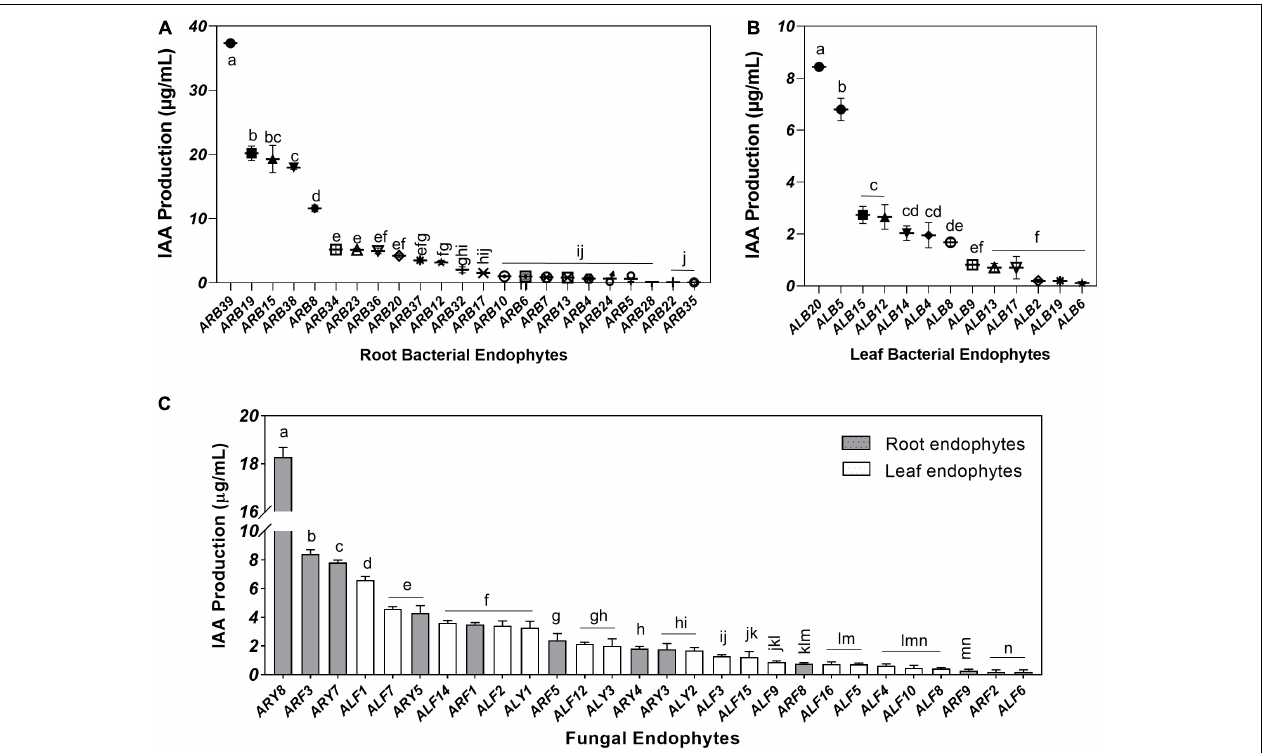
FIGURE 6 | Indole acetic acid (IAA) production by microbial endophytes of A. euchr oma quantified using Salkowski reagent. IAA production by root (A) and leaf (B) associated bacterial endophytes. (C) IAA production by root (gray) and leaf (white) associated fungal endophytes. Bars with different alphabets indicate a significant difference ( p < 0.05) as calculated using Duncan’s multiple-range test. Error bars represent standard deviation ( n = 3).